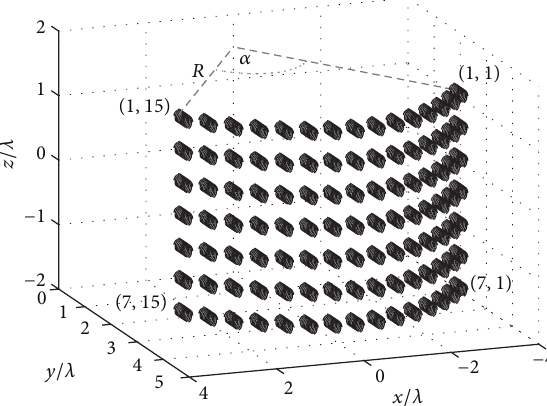
Figure 1: Cylindrical arc array of 𝑁 = 15 × 7 quadrifilar helixes.